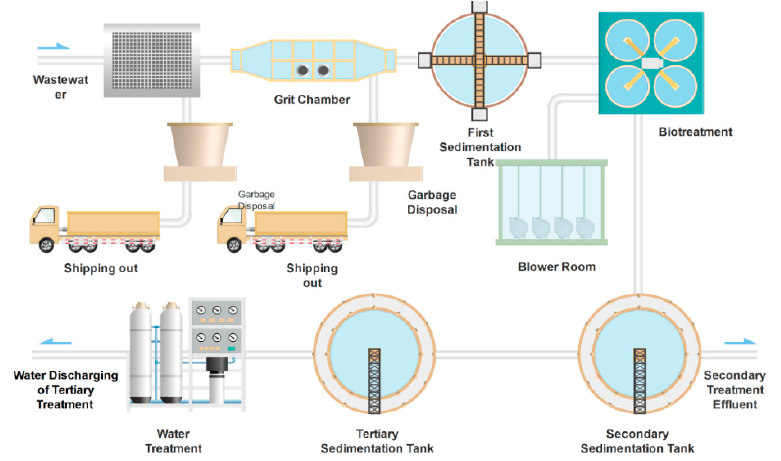
Figure 1. The wastewater treatment process in the sewage treatment plant.